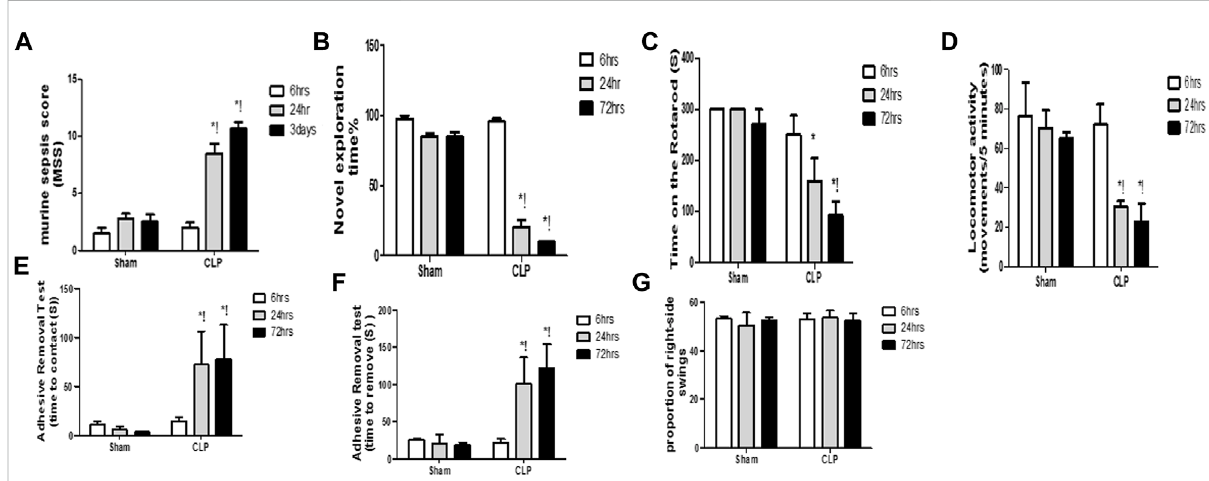
FIGURE 1 Altered cognitive, behavioral and motor coordination functions with sepsis. Murine sepsis score (MSS) (A) is signi fi cantly-induced by CLP. CLP decreasedthepercentageofthenovelobjectexploration time (B) ,thetimespentontherotarod (C) ,andthelocomotoractivity (D) at6,24,and72 h post-sepsis. The time for contact with (E) and removal of (F) the tape was signi fi cantly increased at 24 and 72 h after CLP. An asymmetrical motor behaviorcouldnotbeobservedaftertheelevatedbodyswingtest (G) .Dataarethemeans±SEM.* p < 0.05vs.thecorrespondingshamgroup;! p < 0.05 vs. the 6 h CLP group; and # p < 0.05 vs. the 24 h CLP group. N = 10 rats per